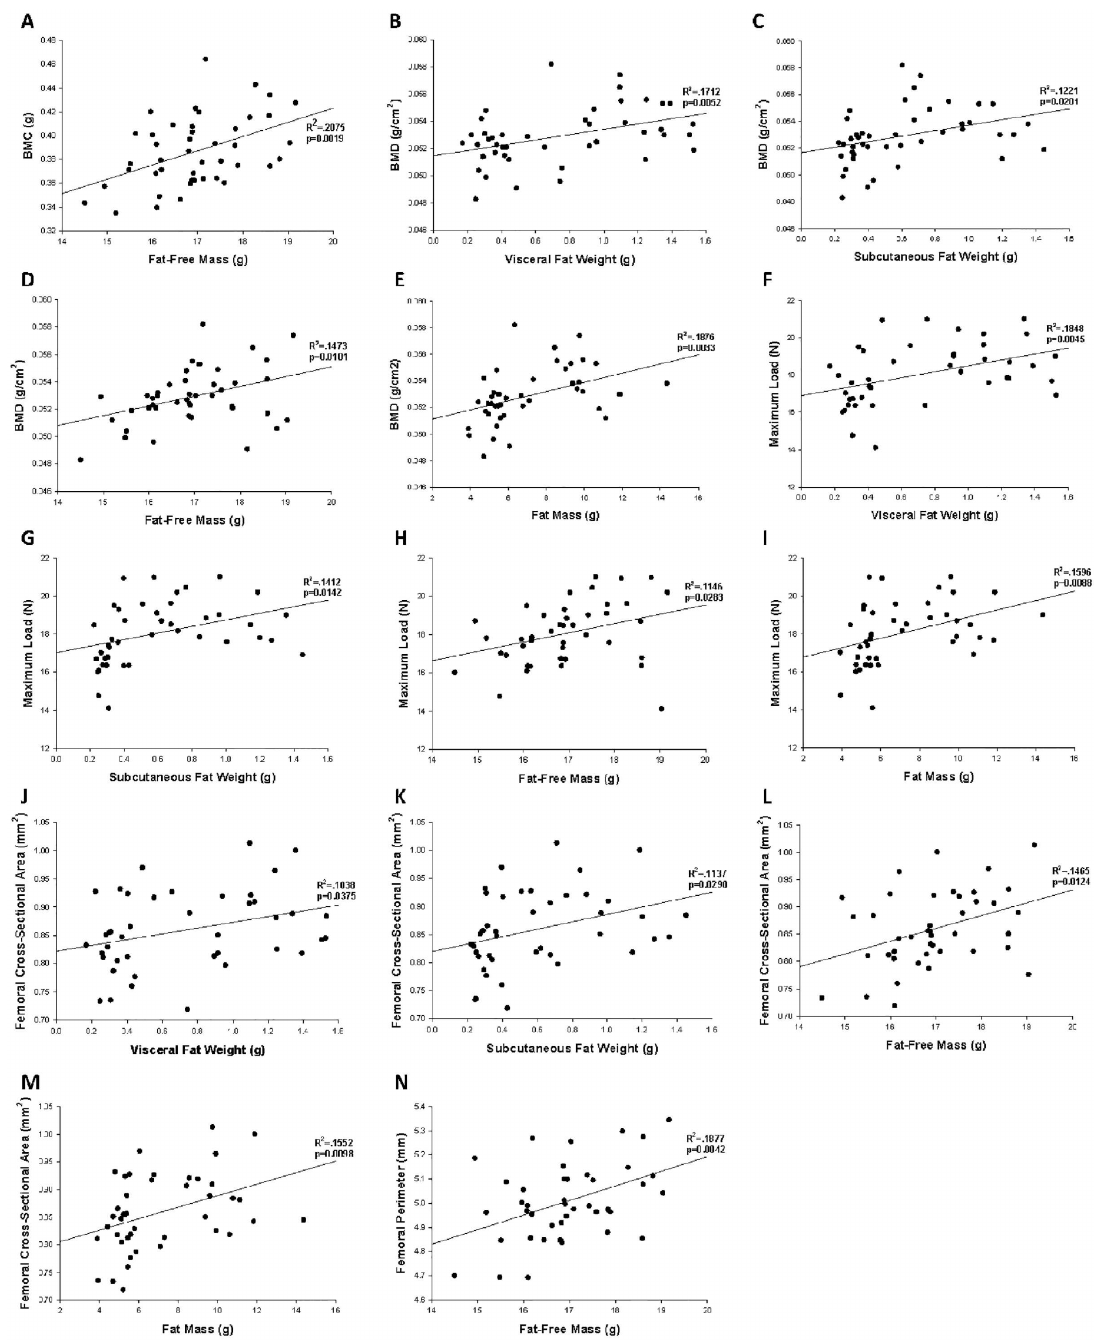
Fig 13. Reciprocal relations of body composition and bone measures. Reciprocal relations of fat-free mass, fat mass, visceral fat weight, and subcutaneous fat weight with measures of mineralization (A-E), strength (F-I), and cross-sectional dimensions (J-N) of the